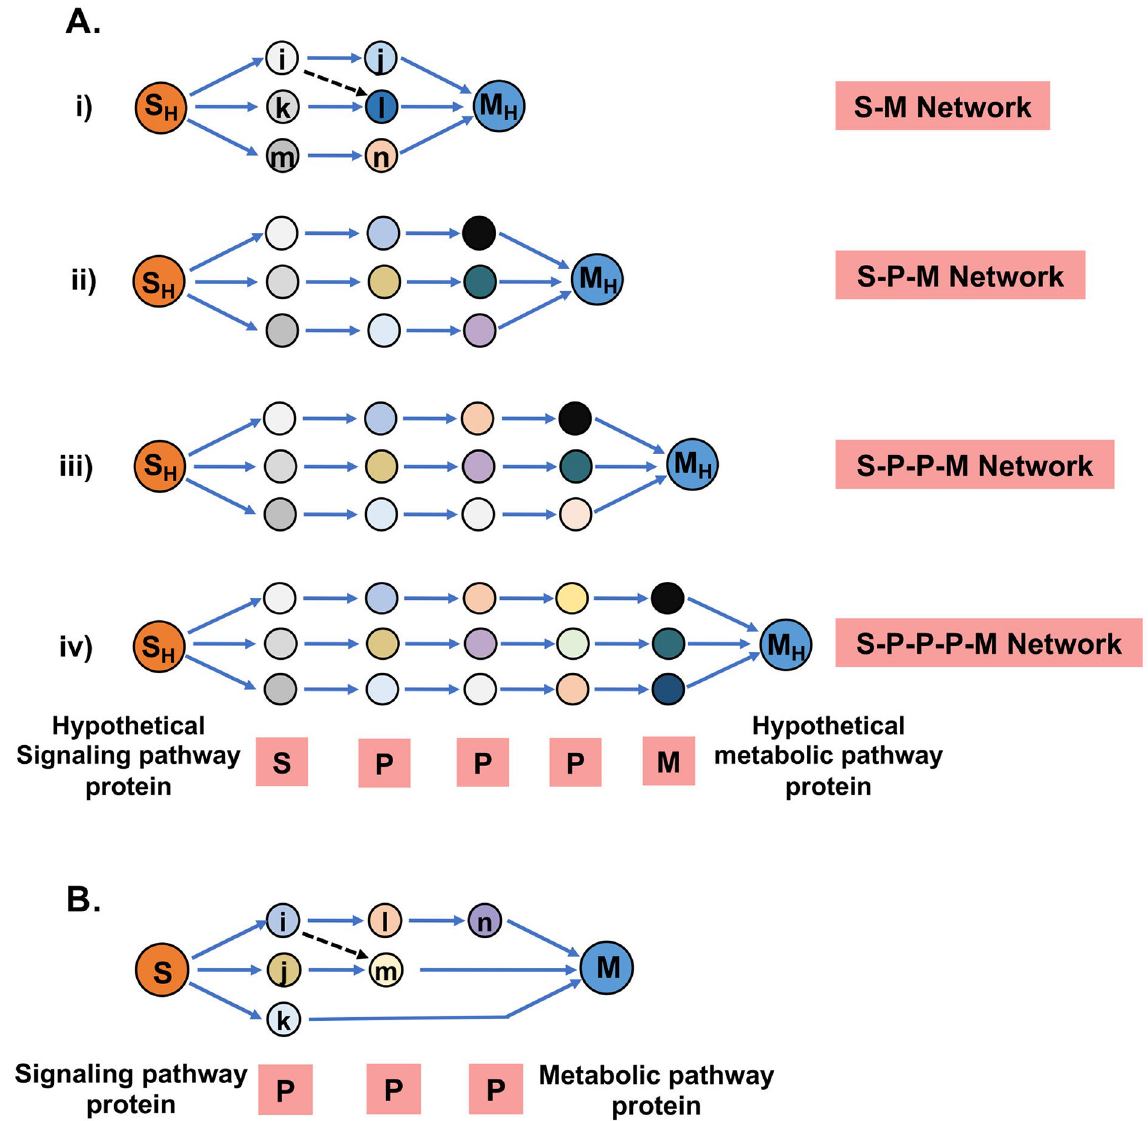
Fig 5. Models for the identification of significant signaling-metabolic (SM) pathway protein pairs and interconnecting paths. Models were implemented to identify significant SM pairs and paths from the weighted network. Weights of the nodes were defined based on whether the proteins were differentially expressed (dEXP), signal crosstalk (SC) proteins, rate-limiting enzymes (RLE) or none of these. The edge weights were defined as interaction probabilities derived from the gene expression values of two interacting proteins in GBM patients. (A) Model 1 was used to identify significant SM pairs from the GBM-specific weighted network. Four types of interconnection with none, one, two and three PPIs between S-M pairs were considered as separate models (i to iv). Two hypothetical proteins were considered on each side (S H and M H ) to implement positional probabilities based on the node weights of all proteins including S and M. Using these models and the Hidden Markov Model (HMM) logic, the path scores were calculated from the node and edge weights. The path scores were converted to Z-scores, and scores above the cut-off value of Z � 1 or Z � 3 were considered as significant and highly significant, respectively, and the respective interconnected SM pairs as significant pairs. (B) Model 2 was used to identify important linking-paths among the total possible paths formed between significant SM pairs from Model 1. Path scores were calculated from the positional probabilities as above. Higher path scores indicate higher significance. the proteomic expression states of the source (S) and destination (M) proteins as UP-DOWN, UP-UP, DOWN-UP, and DOWN-DOWN. Including unidentified proteins in proteomics analysis (NA) of the cell lines, the couplet categories UP-NA, DOWN-NA, NA-UP and NA-UP, and unchanged expression states (NC) in the cell lines with SM categories UP-NC,